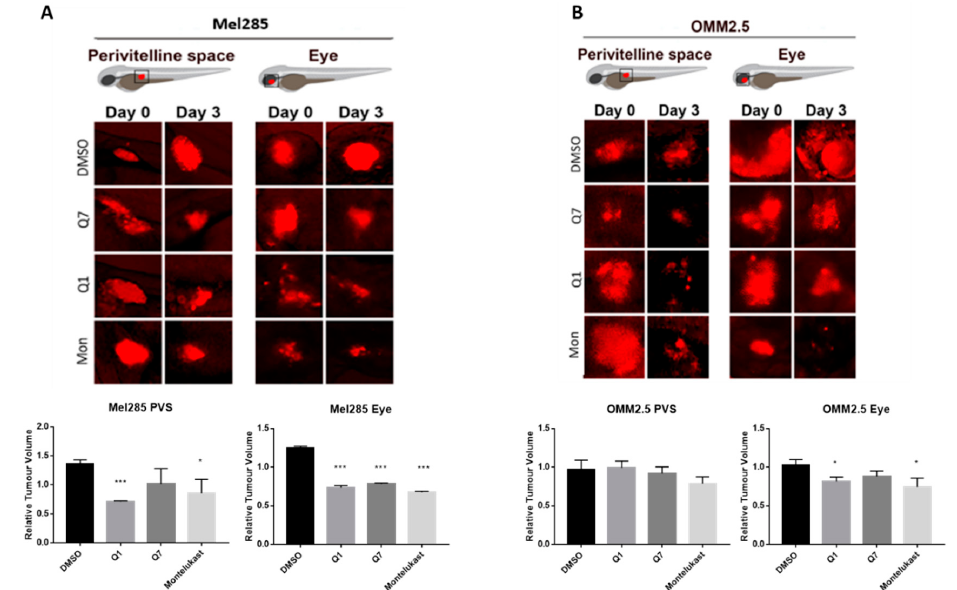
Figure 10. CysLT 1 antagonists inhibit the growth of UM cell lines in in vivo zebrafish xenograft models . Zebrafish cell line-derived xenograft models were developed using Mel285 and OMM2.5 cell